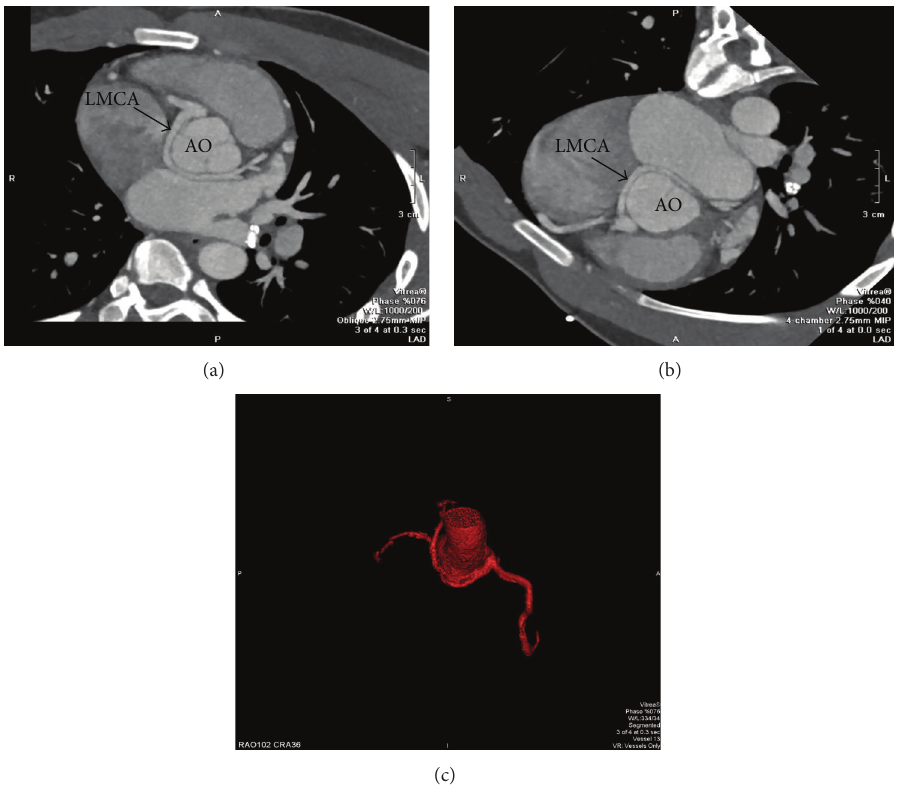
Figure 6: Cardiac computed tomography and three dimensional reconstruction showing an anomalous left main coronary artery (LMCA) off of the right sinus of Valsalva assuming a posterior course around the aorta